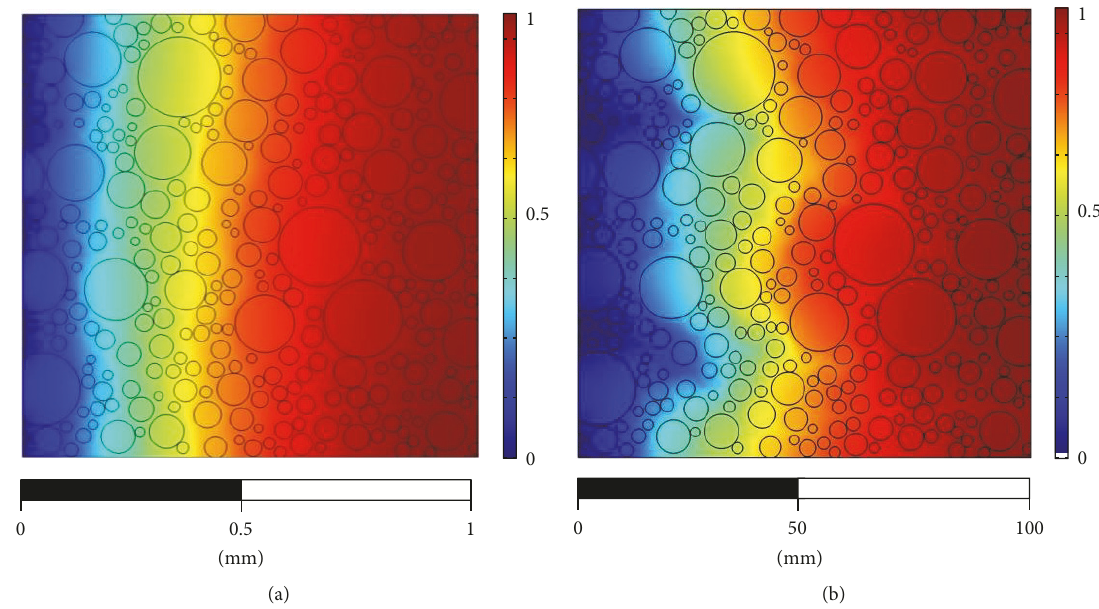
Figure 7: Relative Temperature (RT) within the computational domain. For the model with the length scale of 1 mm (a) it takes 0.26 seconds for the heat to reach the Relative Temperature of 0.5 at the center of the domain, whereas for the model with the length scale of 100mm (b) it takes 471 seconds.